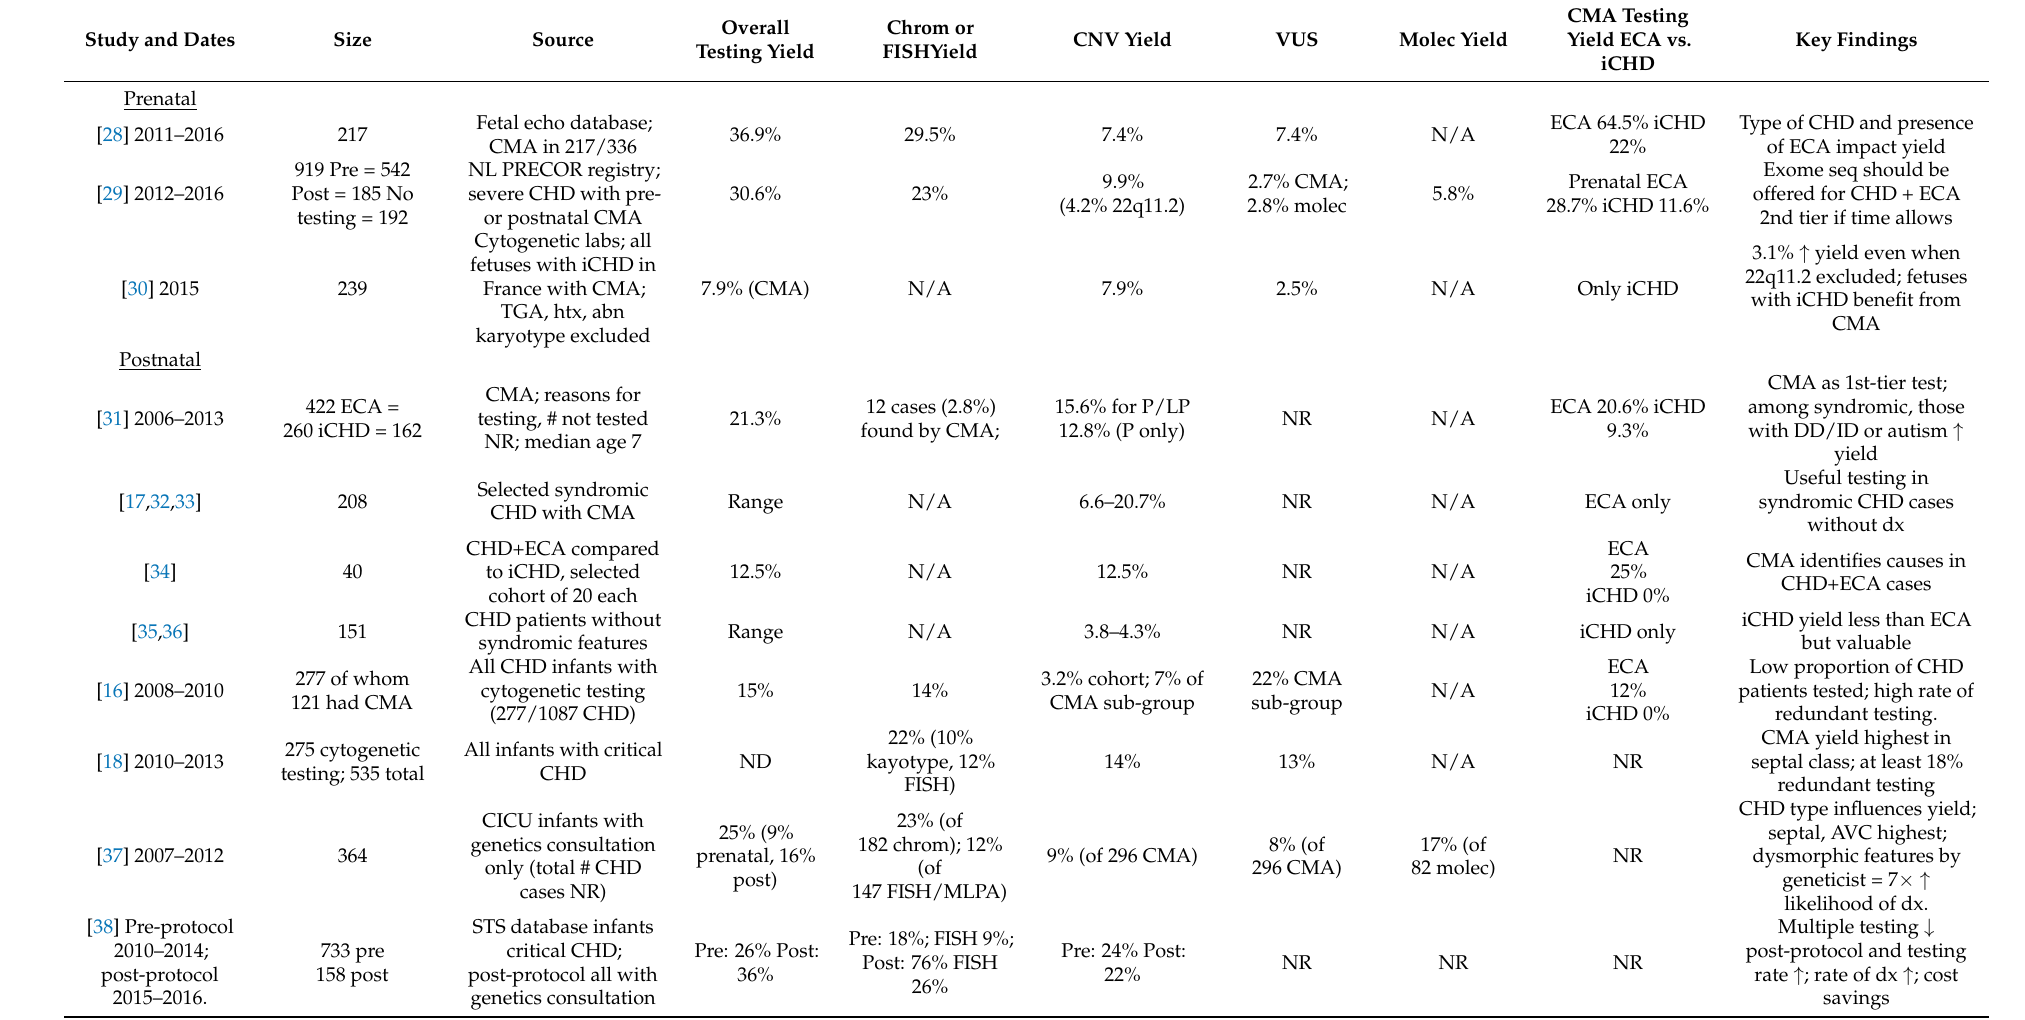
Table 6. Summary data from key publications on genetic testing in fetuses or infants with